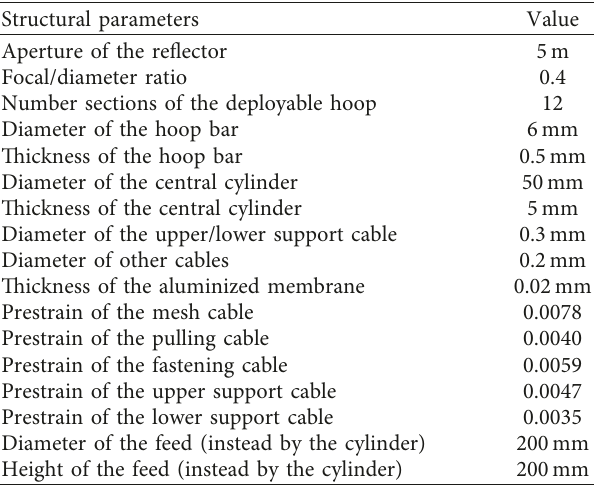
Table 2: Structural parameters of the CMMR and ECD.